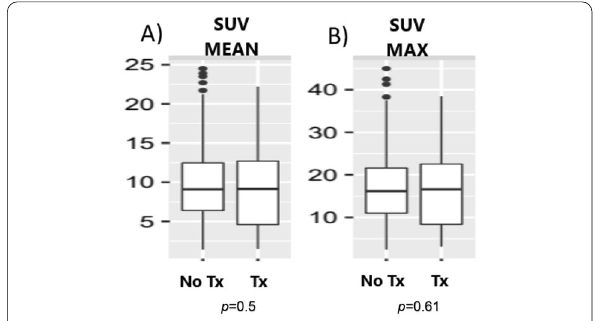
Fig. 1 Box Plot of SUV in steroid naïve (no Tx) and steroid‑treated (Tx) patients. A SUV mean, B SUV max.